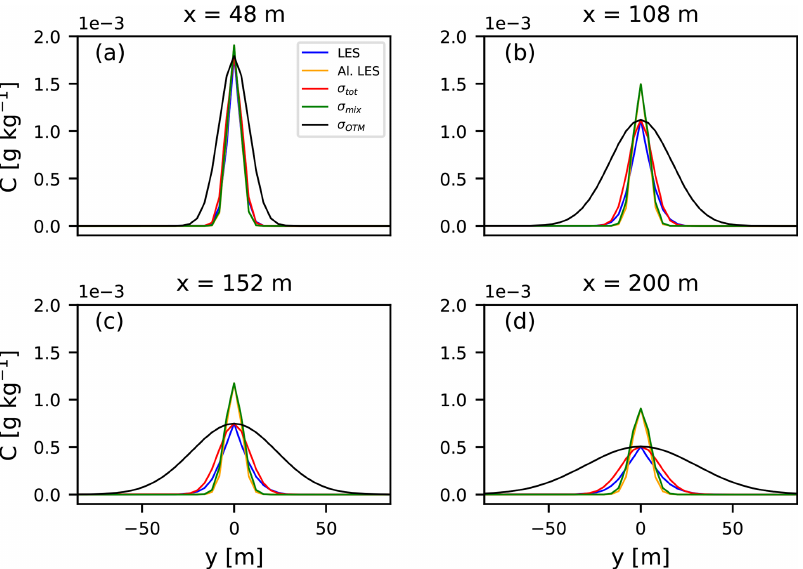
Figure 11. Time averages of instantaneous plumes (blue) on the plume centerline and the instantaneous plumes aligned according to their centers of mass (orange), in the y direction. Fitted through them are Gaussian functions with 1 standard deviation of their width σ i (m) (green: mixing; red: total). For reference, we show Gaussian functions fitted to the maximum of the non-aligned plume with σ taken from OTM 33A (black). Emission and sampling heights are